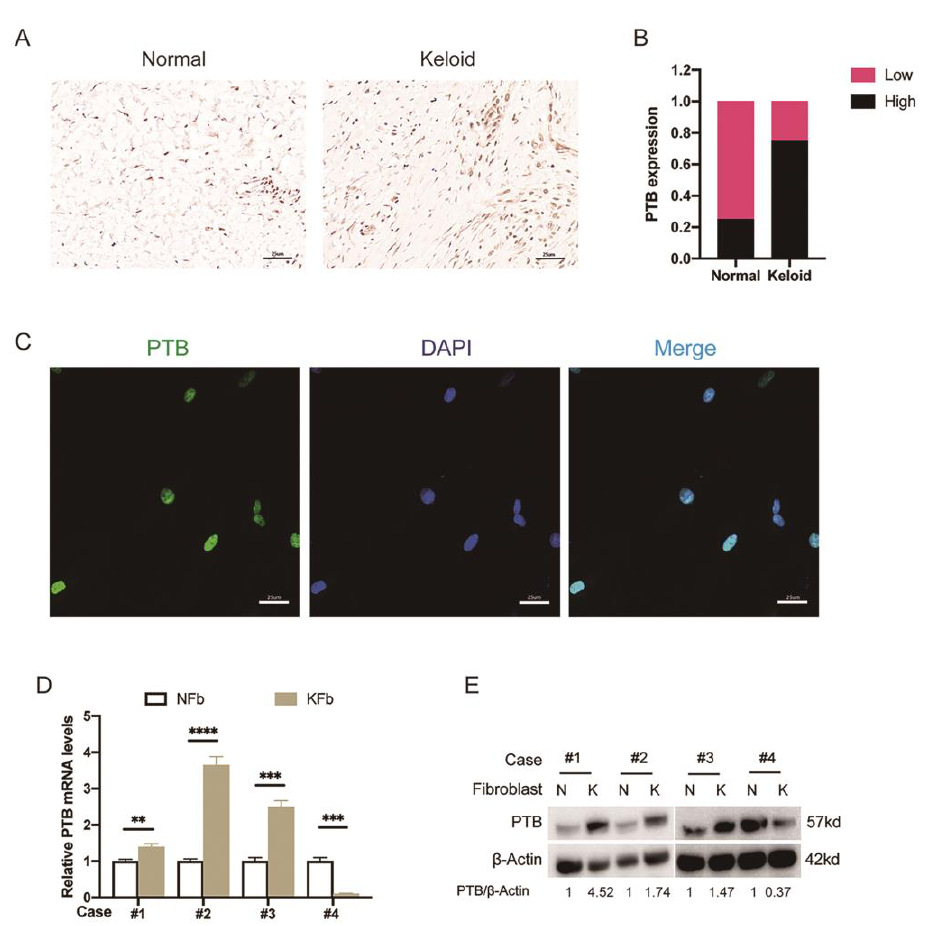
Figure 1. The aberrantly upregulated PTB in keloid samples. ( A ) The expression of PTB was detected in keloid tissues and the adjacent normal skin tissues by IHC. Representative images are shown at 400 × magnification. ( B ) Differences in the expression scores of PTB between keloid tissues and the corresponding normal tissues are presented as a histogram ( n = 4). ( C ) Confocal microscopy was used to observe KFb immunostained with anti-PTB antibody. ( D ) PTB mRNA levels in the KFb ( n = 4) and the matched adjacent NFb ( n = 4) were detected by qRT-PCR. ( E ) PTB protein levels in the KFb ( n = 4) and matched adjacent NFb ( n = 4) were detected by Western blotting. Data are presented as the mean ± S.D. ** p < 0.01, *** p < 0.001, **** p < 0.0001.